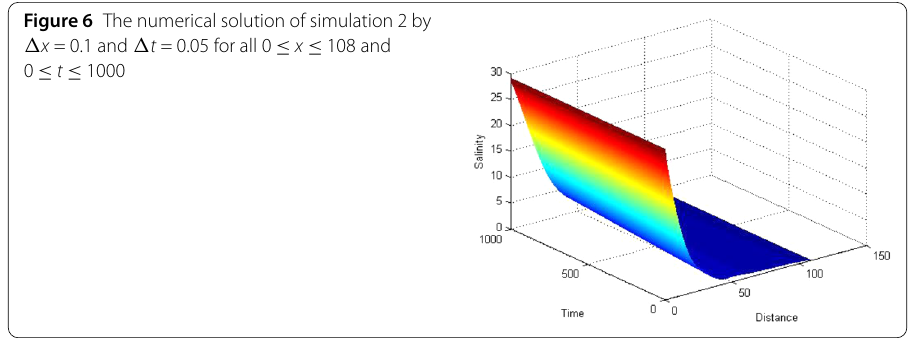
Figure 6 The numerical solution of simulation 2 by (cid:4) x = 0.1 and (cid:4) t = 0.05 for all 0 ≤ x ≤ 108 and 0 ≤ t ≤ 1000